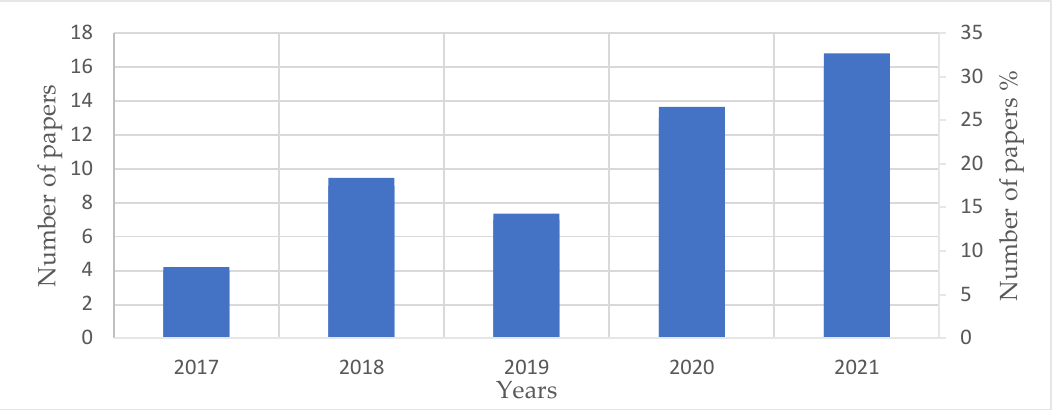
Figure 1. Studies’ number of hybrid ML models for WQ parameters prediction over the last four years.